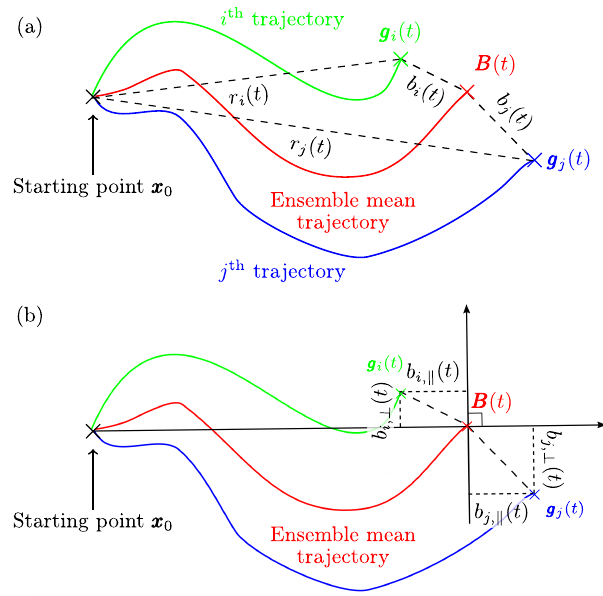
Figure 2. From a 12-member ensemble of simulated trajectories of a virtual buoy drifting during 10 days of which only two of them, denoted i and j , are drawn, we represent the distances (a) r and b and the coordinates (b) b (cid:107) and b ⊥ for the virtual buoy i and j at time t